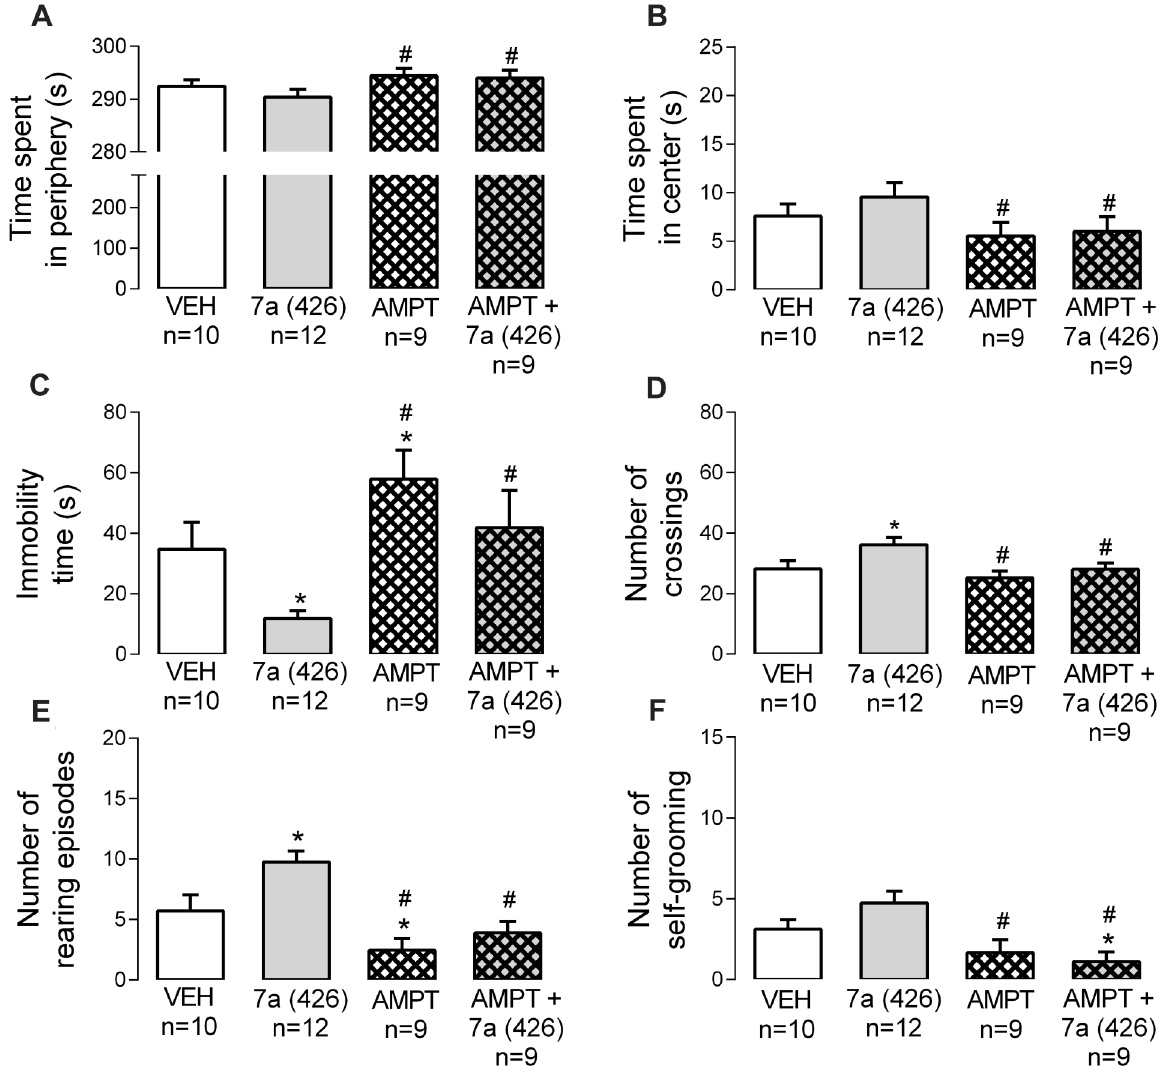
Figure 6. Contribution of catecholaminergic pathways (as revealed by the depleter a -methyl-DL-tyrosine) to the effects evoked by Bj- PRO-7a on locomotion/exploration in the open fi eld. A , Time spent in periphery; B , Time spent in center; C , Immobility time; D , Number of crossings; E , Number of rearing episodes; F , Number of self-grooming espisodes. Experimental groups: VEH: vehicle (0.9% NaCl); 7a (426): Bj-PRO-7a (426 nmol/kg); AMPT: a -methyl-DL-tyrosine (200 mg/kg); AMPT + 7a (426): co-administration of a -methyl-DL-tyrosine and Bj-PRO-7a (426 nmol/kg). Data are reported as means ± SE. *P o 0.05 vs vehicle; # P o 0.05 vs 7a (426) (one-way analysis of variance followed by Fisher ’ s post hoc